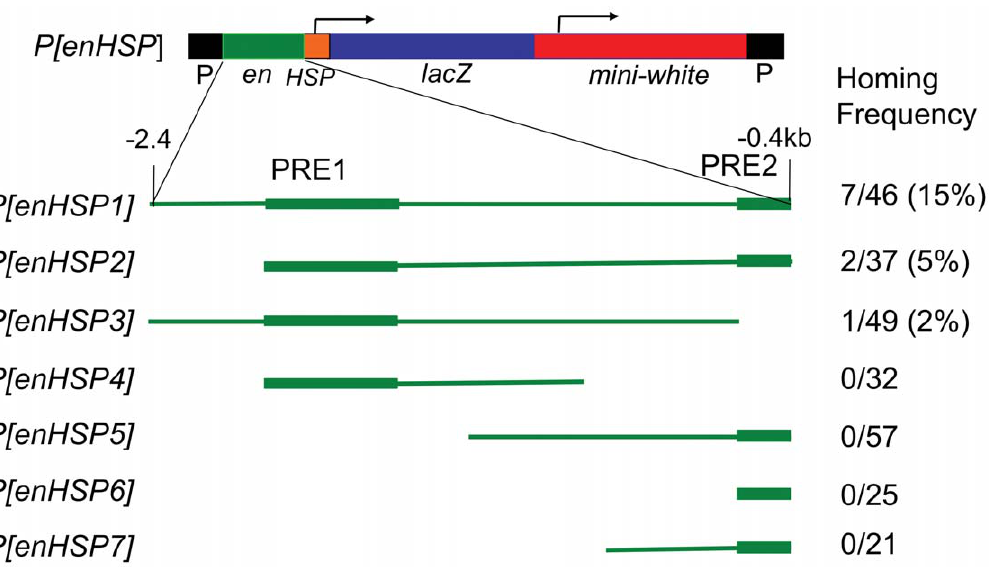
Figure 3. P[enHSP] constructs used to dissect the homing fragment. The P[enHSP] construct is shown on top with the extent of the en DNA present shown below by the green line. The PREs are shown as thicker areas of the green line. The homing frequency is shown on the left; the number of insertions in the en/inv region/the total number of transgenic lines recovered is shown on the right side. P[enHSP1] , P[enHSP2] , and P[enHSP3] are from [12].